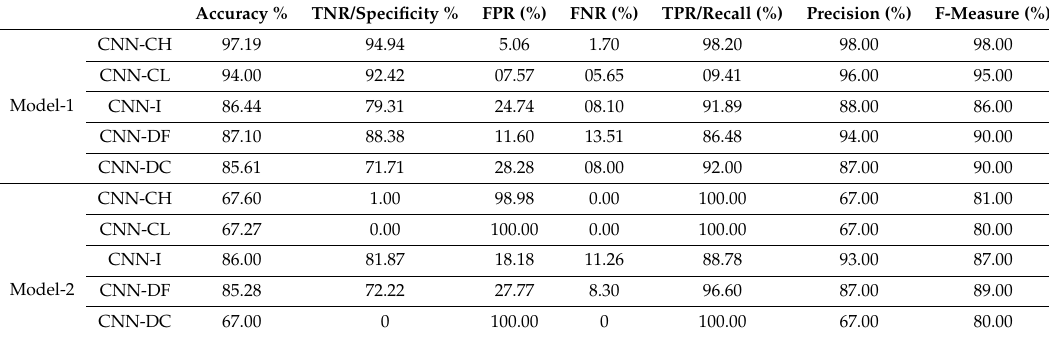
Table 5. Performance of various cases on 200 ×